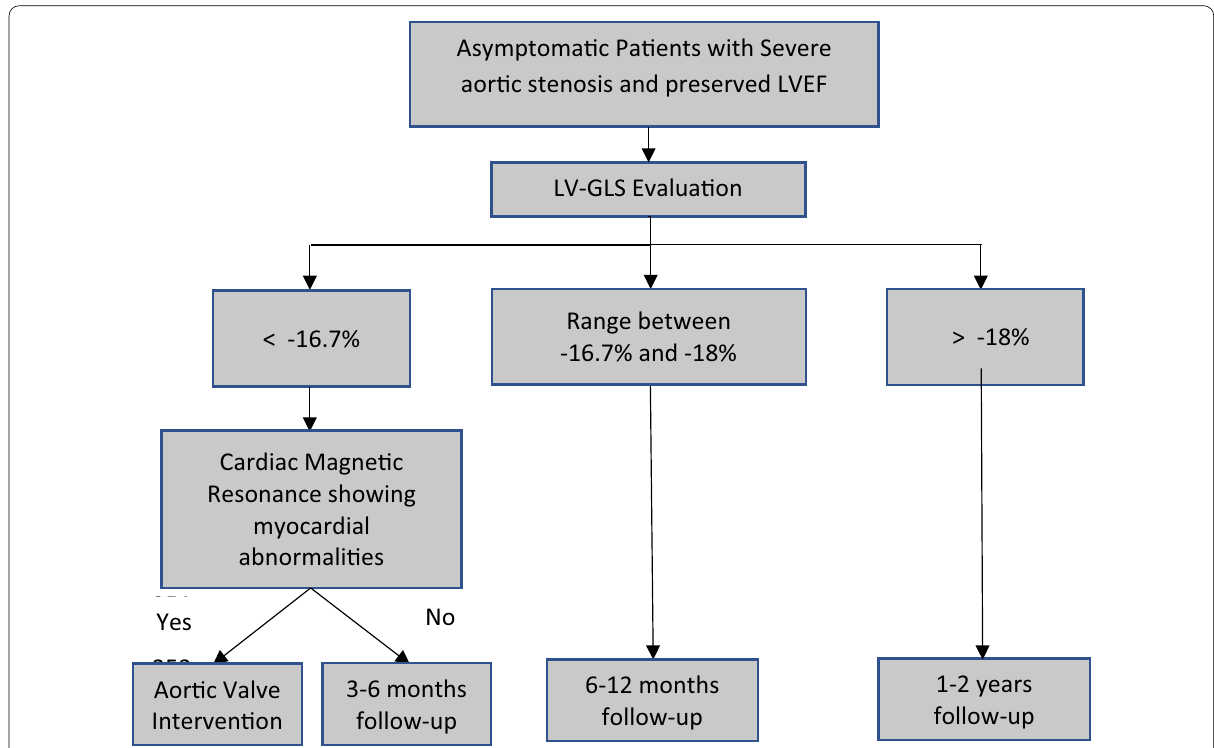
Fig. 3 Algorithm for asymptomatic patients with severe aortic